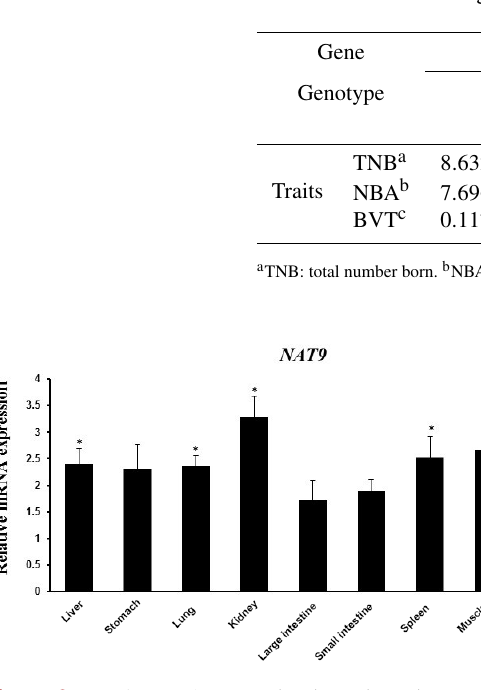
Table 8. Association of litter size traits with MAP3K3 genotypes in the secondary experiment.